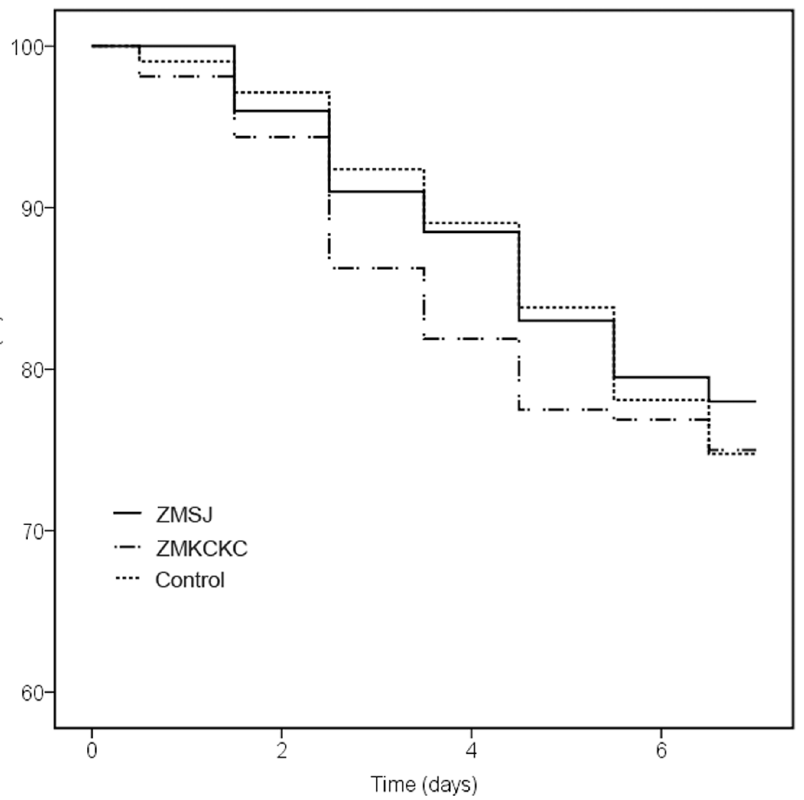
Figure 1. Survival analysis of honey bees from groups subjected to chronic exposure to ZMSJ pollen, ZMKCKC pollen and non-Bt pollen after 7 days. Data were analyzed with Cox proportional hazards regression models, and no significant differences were found among all the treatments at the P . 0.05 level.